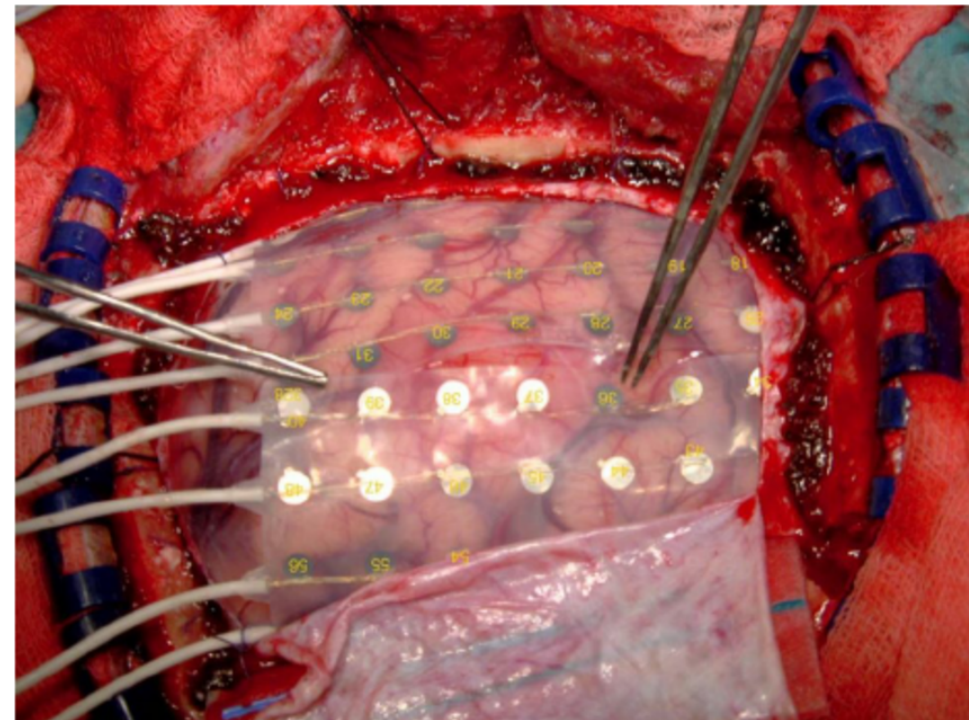
Figure 3. Sample net of electrodes placed on the cortex surface